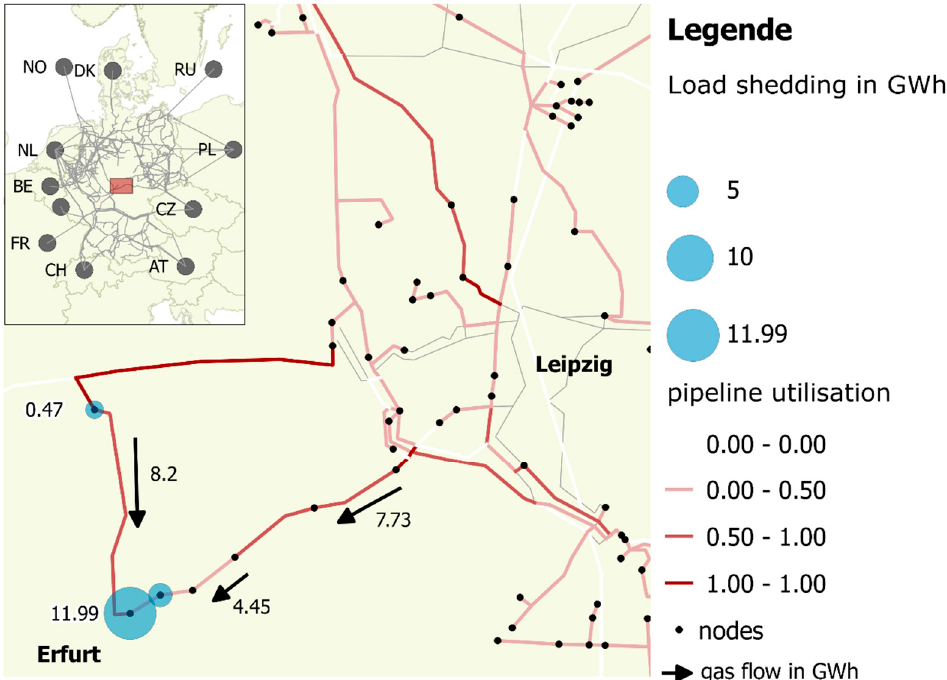
Figure 16. Results of GAMAMOD-DE for pipeline utilization on 13th of December 2030.